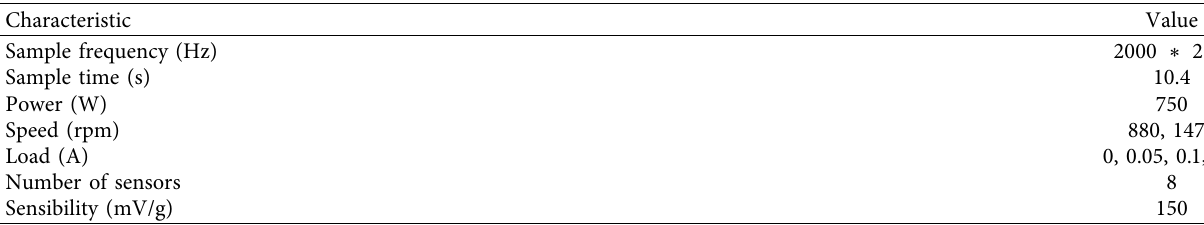
Table 1: Sampling situations.